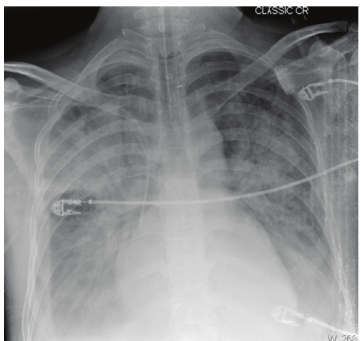
Figure 1: Anteroposterior chest radiography, which shows diffuse pulmonary congestion with bilateral pleural